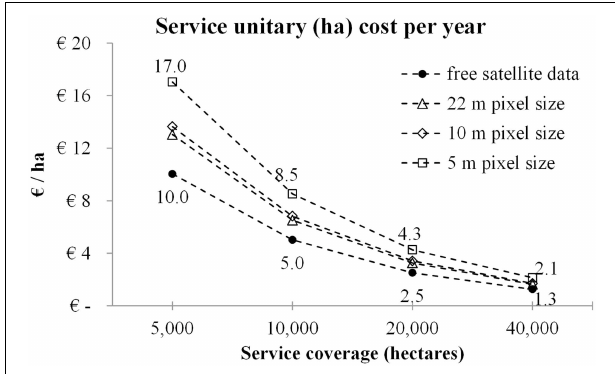
FIGURE 7 | Service cost per hectare (ha) and per growing